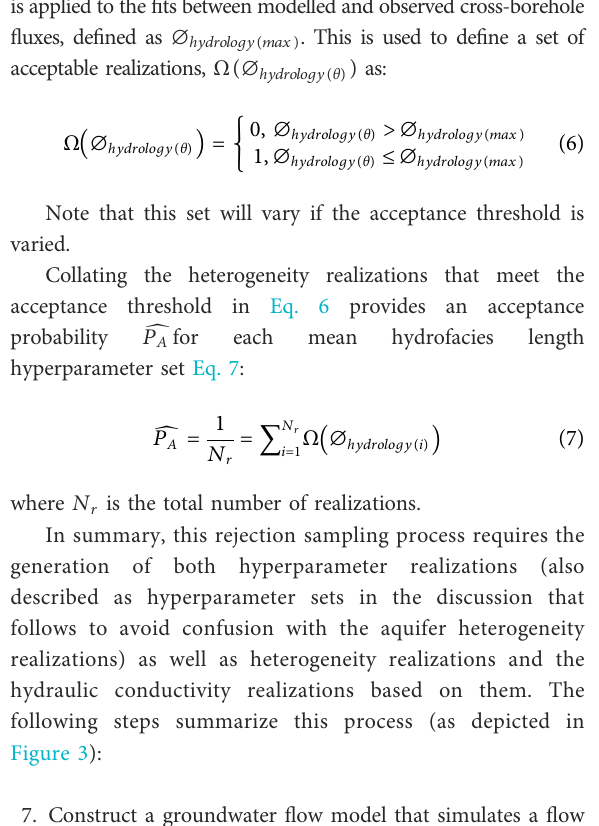
7. Construct a groundwater fl ow model that simulates a fl ow fi eld to represent the cross-borehole connectivity observations revealed by the smoke tracer test. 8. Select a subset of hyperparameter realizations that span the range of mean OFG length values de fi ned in step 6 and generate an ensemble of heterogeneity realizations on the basis of each selected hyperparameter realization.